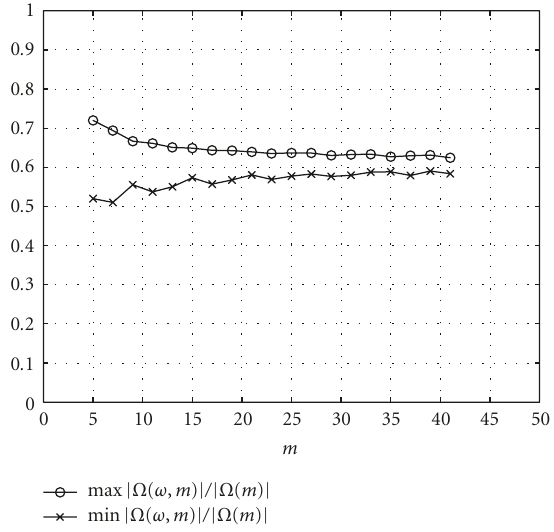
Figure 2: Numerical evaluation of | Ω ( ω , m ) | / | Ω ( m ) |